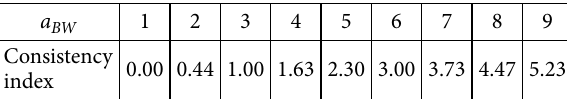
Table 1. The consistency index of